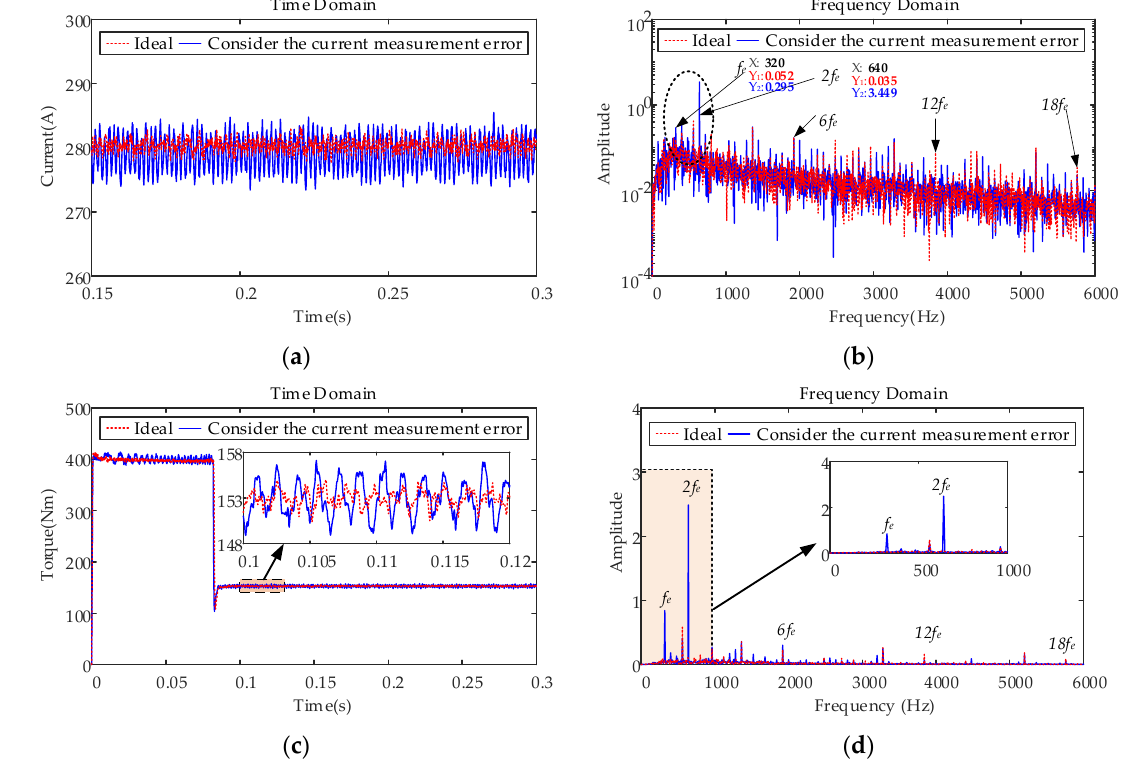
Figure 21. Comparison results of current and electromagnetic torque : ( a ) time domain of q ‐ axis current; ( b ) frequency domain of q ‐ axis current; ( c ) time domain of electromagnetic torque; ( d ) frequency domain of electromagnetic torque.